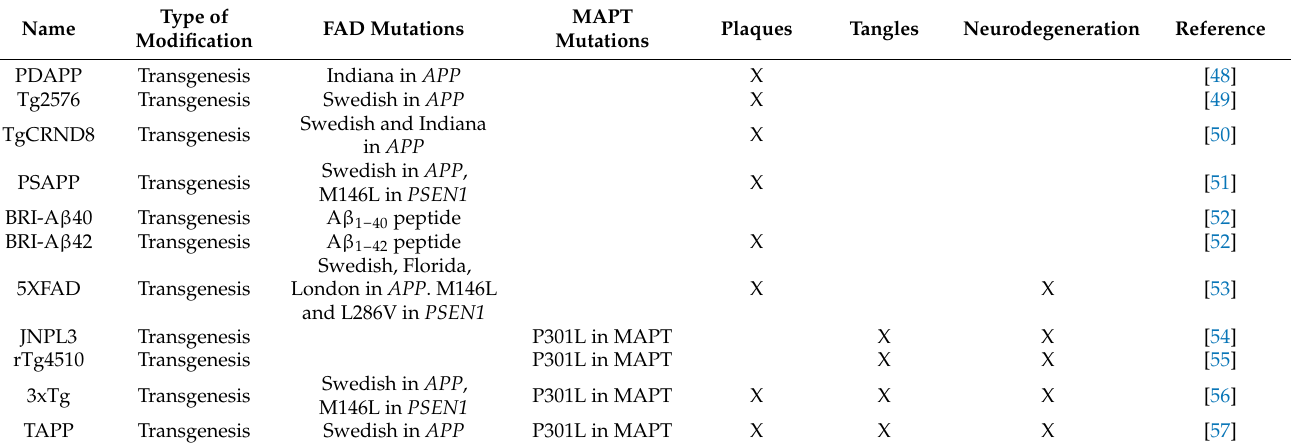
Table 1. Selected key mouse models of AD and their major